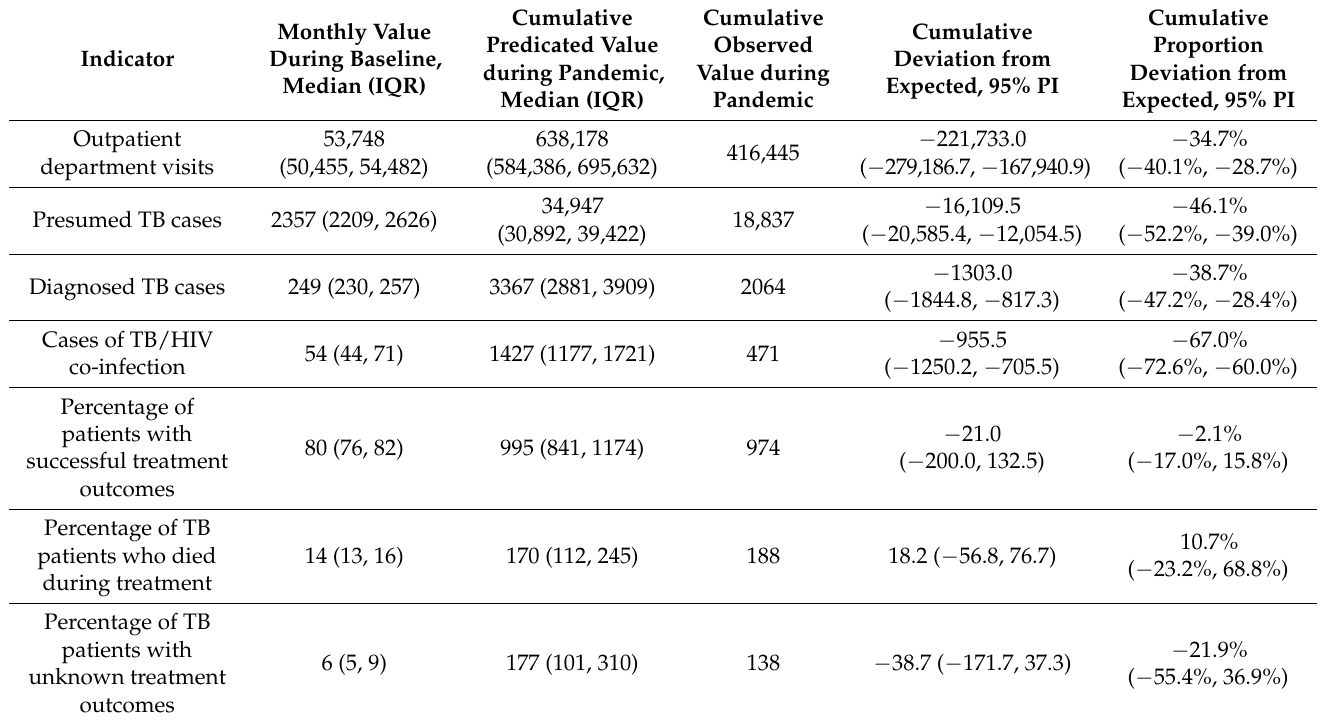
Table 2. Cumulative deviations in seven TB program indicators during March 2020 to March